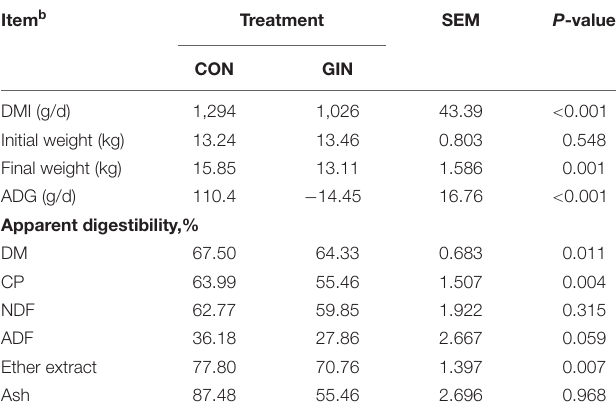
TABLE 2 | Growth performance and dietary nutrient apparent digestibility of lambs infected with Haemonchus contortus a .